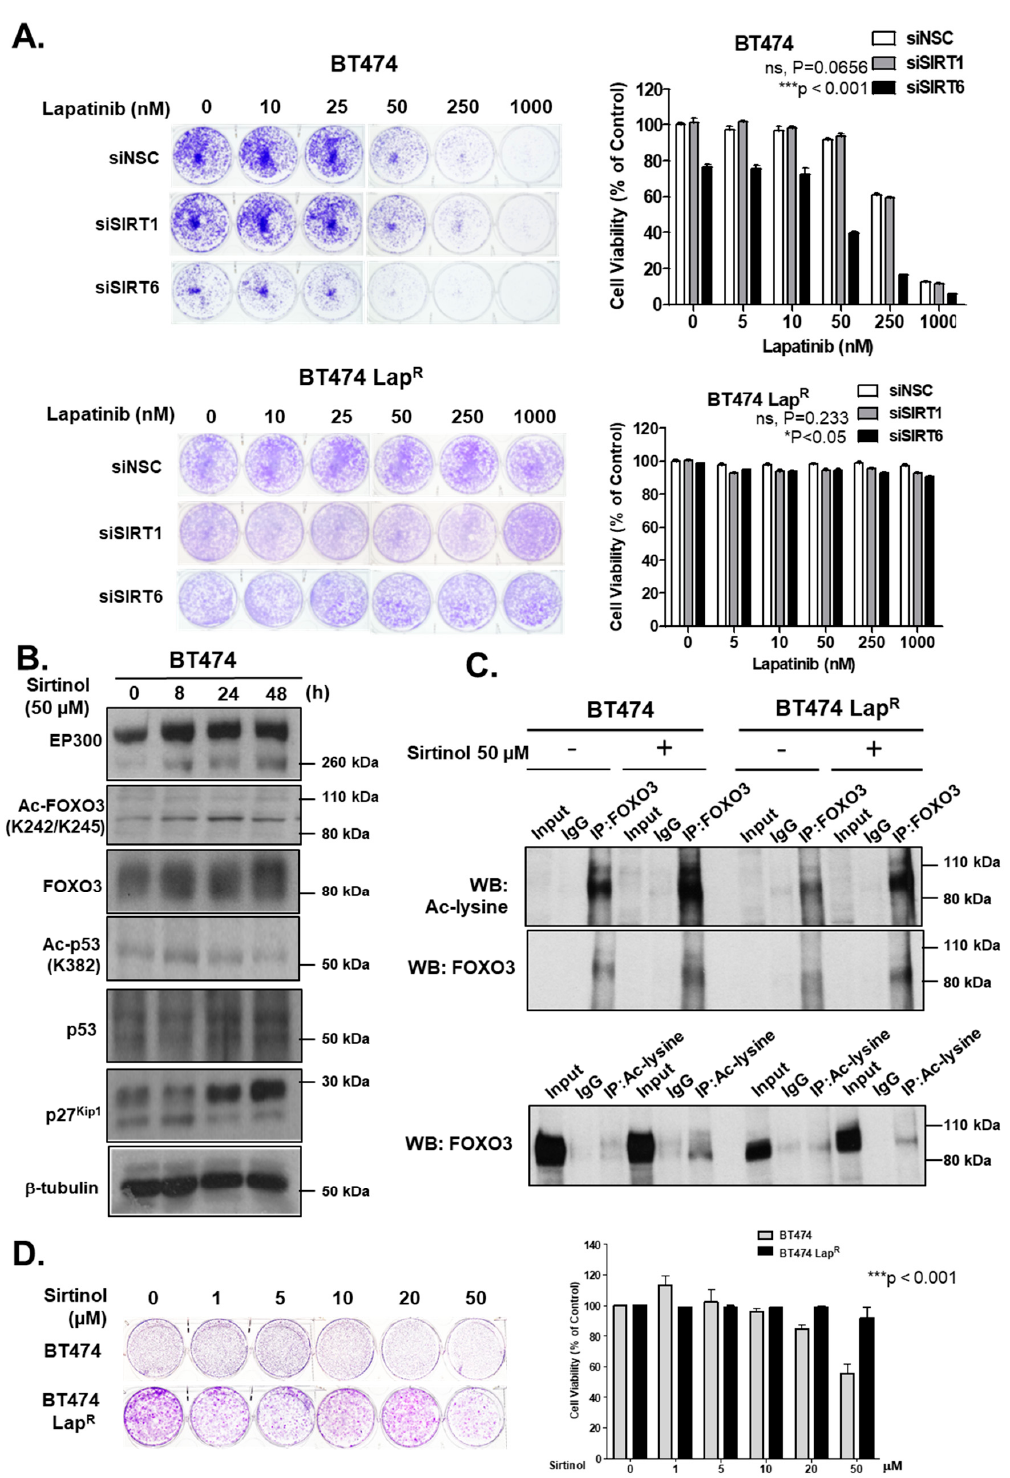
Figure 7. Silencing of SIRT6 as well as its inhibitor sirtinol increases long-term lapatinib cytotoxicity in BT474 cells. ( A ) BT474 and BT474 Lap R cells were transfected with siNSC, siSIRT1 or siSIRT6 siRNA smartpool. After 24 h of transfection, 1000 cells were seeded per well, in 6-well plates. Cells were allowed to grow overnight and then treated with the lapatinib concentration indicated (0, 5, 10, 50, 250 and 1000 nM). At the end of this time period, cells were fixed with 4% para formaldehyde and stained with crystal